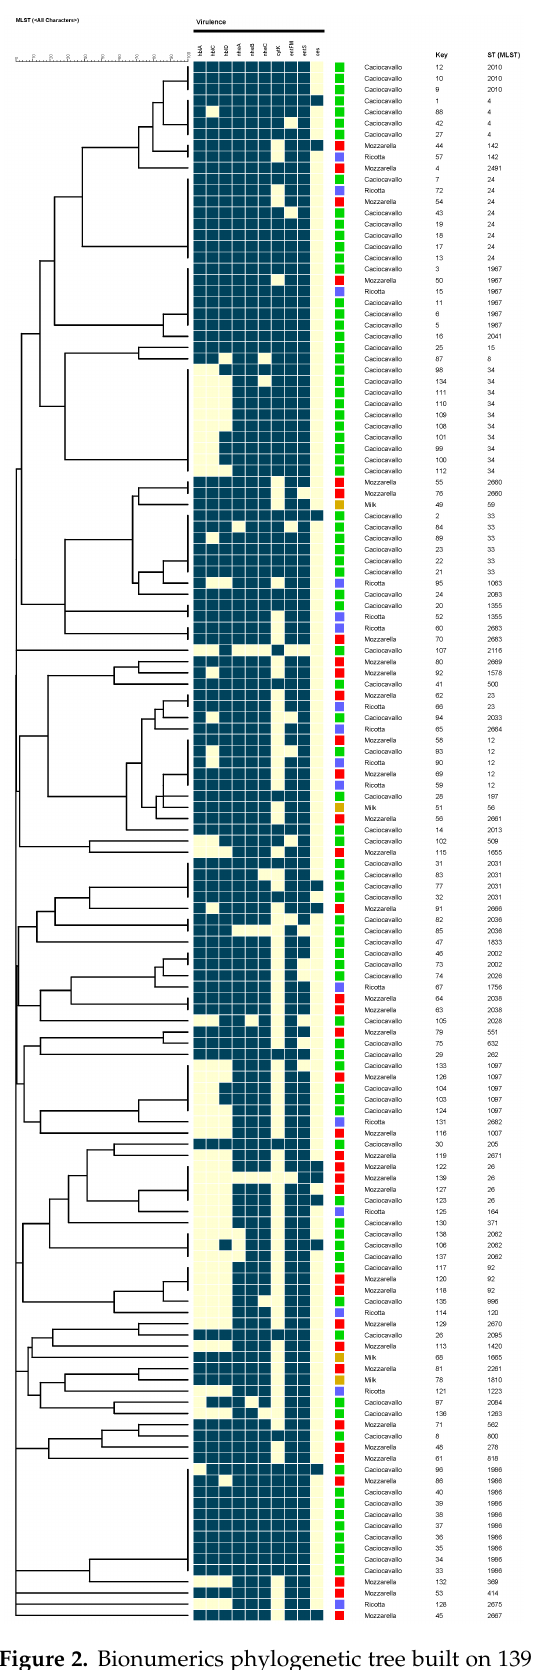
Figure 2. Bionumerics phylogenetic tree built on 139 B. cereus isolates. The tree is based on 73 ST profiles. The presence of virulence factors are marked in blue colour. The source and STs are listed next the tree.